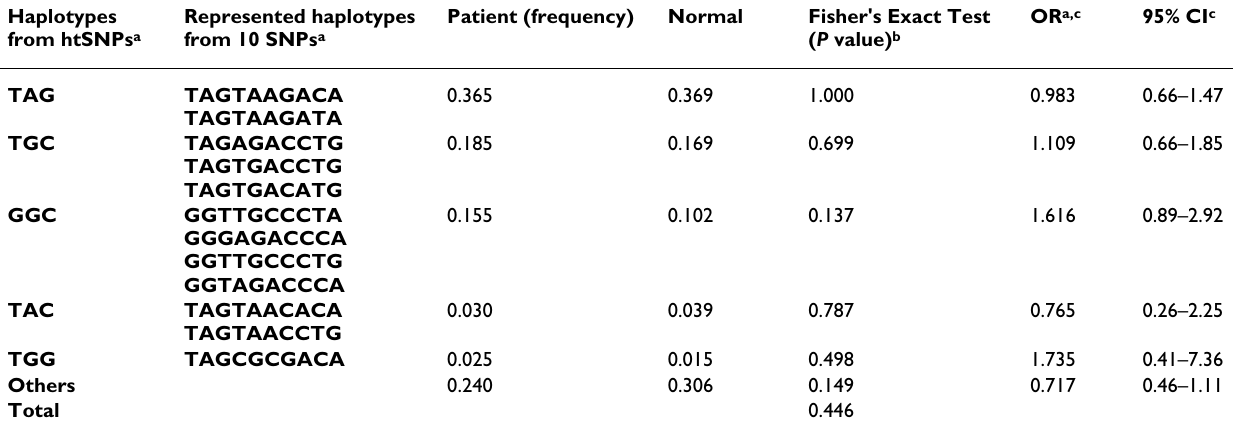
Table 5: Haplotype frequency and test statistics between cases and controls using htSNPs. Haplotypes from htSNPs